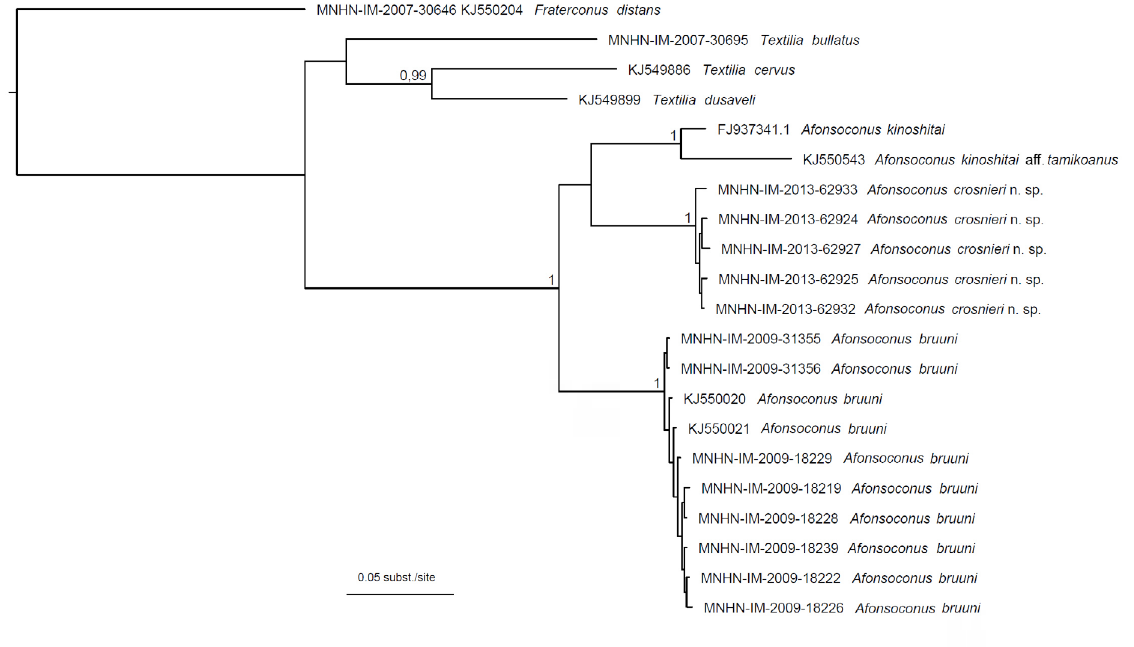
Fig. 3. Bayesian phylogenetic tree. Posterior probabilities (above 0.95) are indicated for each node. Sequences are labelled with the MNHN registration number or the GenBank accession number, and the species